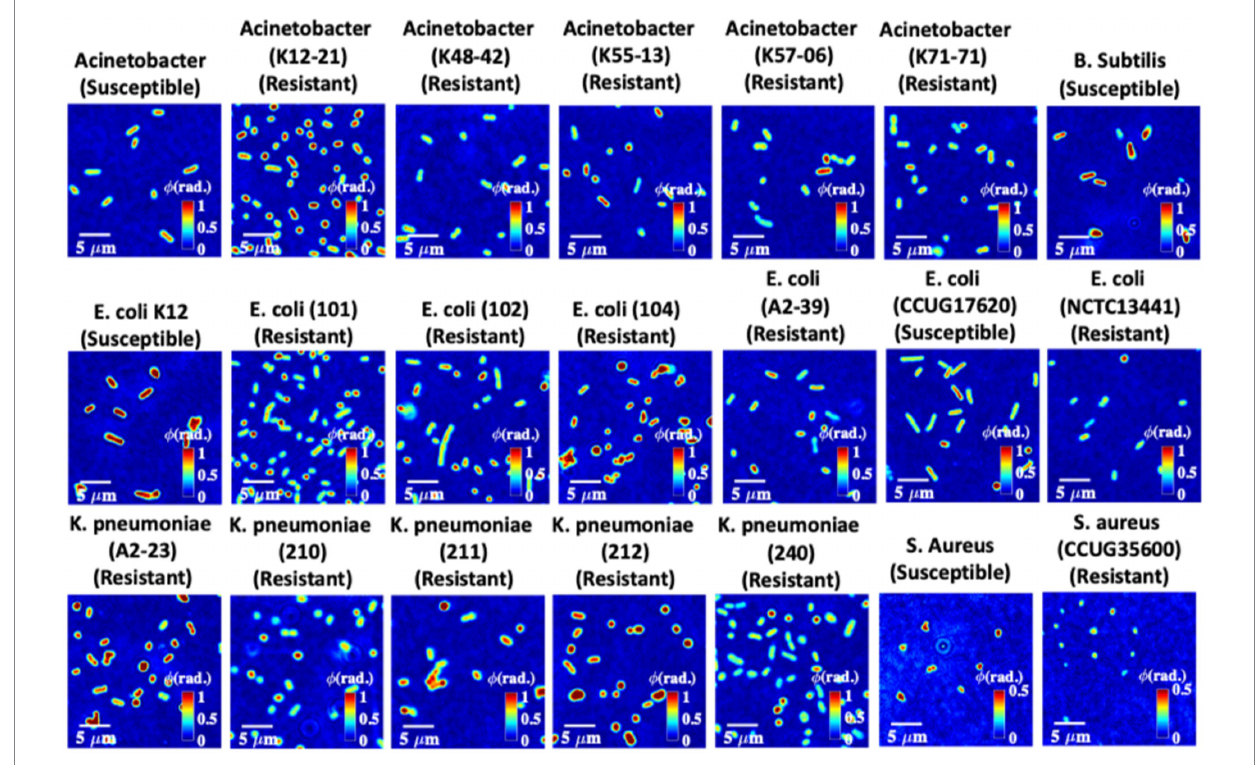
FIGURE 5 Quantitative phase maps of 21 different bacteria strains. The color bars for the bacteria samples are from 0 to 1 rad. Note that the color bars for Staphylococcus aureus strains are from 0 to 0.5